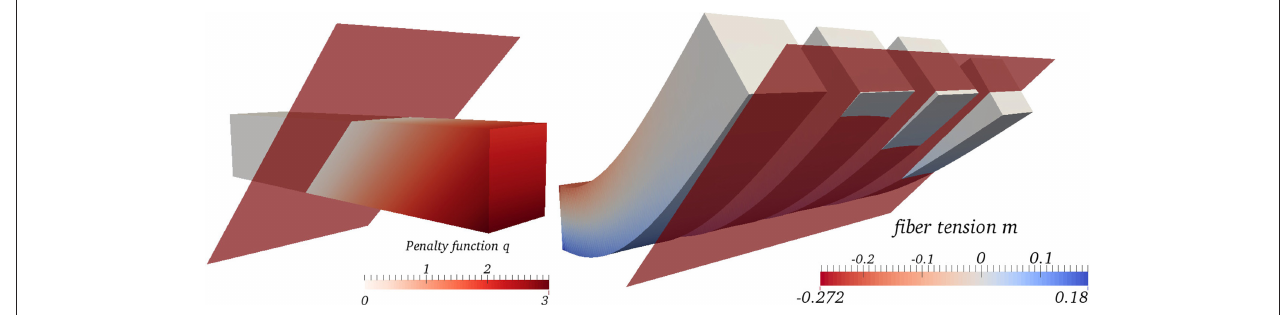
FIGURE 4 | Left: The undeformed body (cid:127) and the half plane H from Example 7. The colored scaling indicates the value of the penalization function q . Right: The deformed body with the fiber tension in red (shorting of fibers) and blue (elongation) for γ